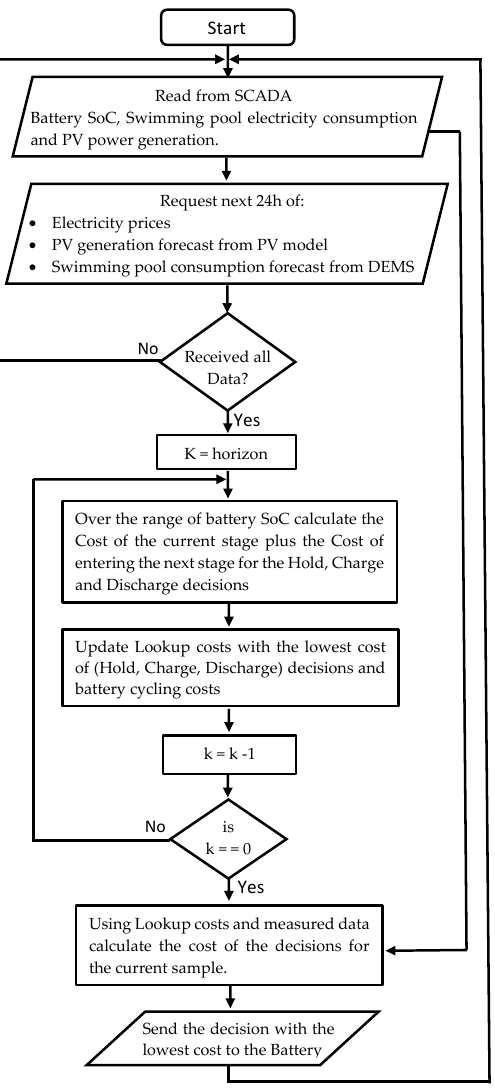
Figure 1. Flowchart of the battery optimisation algorithm.